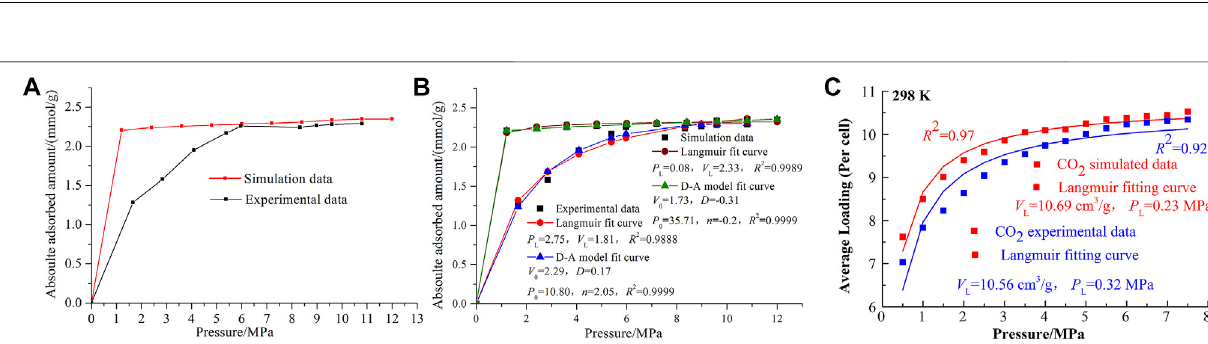
Frontiers in Earth Science |